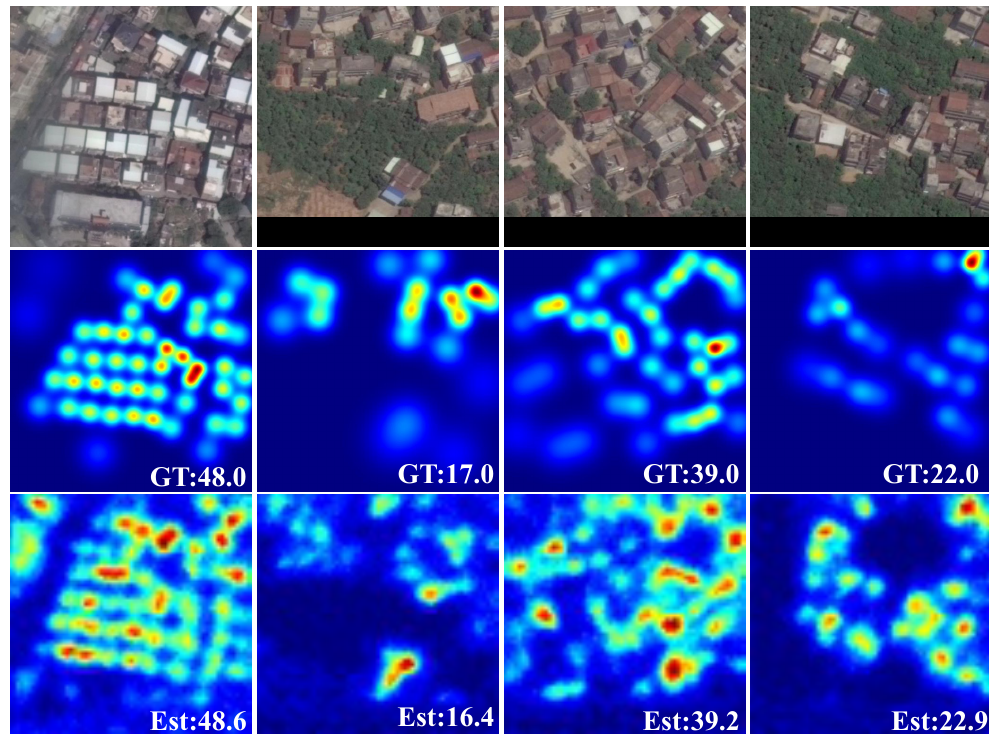
Figure 5. Subjective results on the RSOC_building dataset.